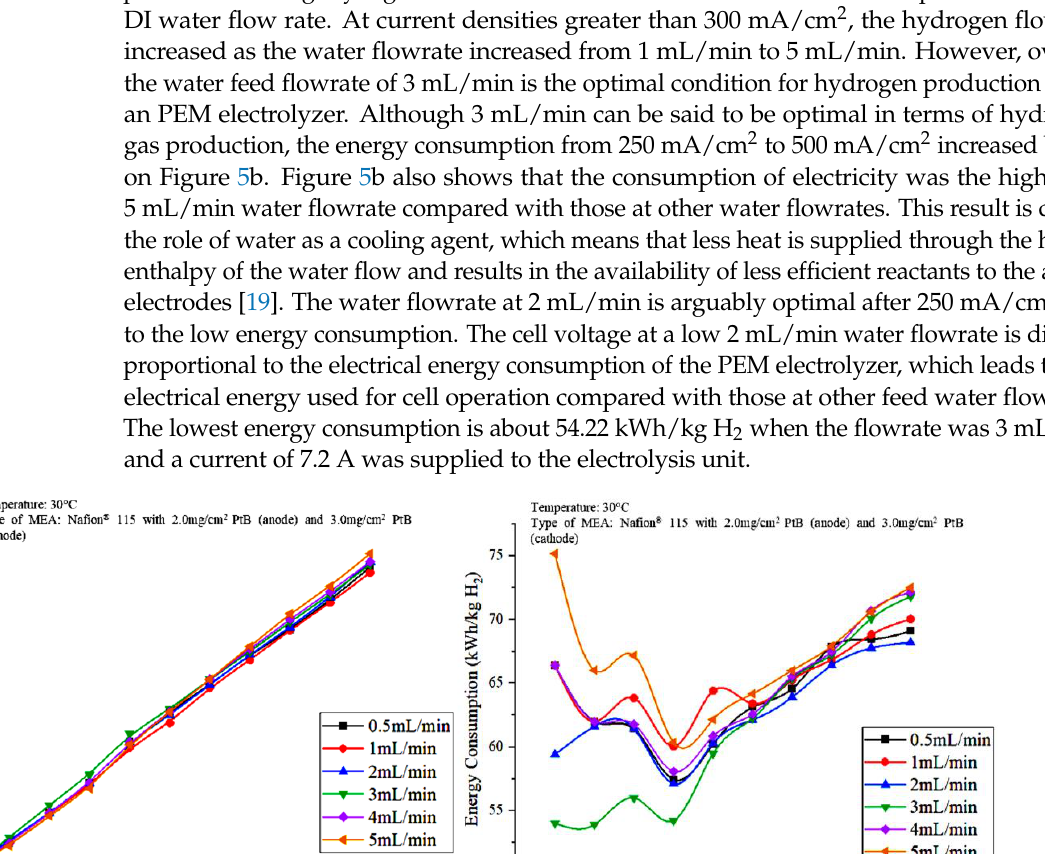
( b ) Figure 6. Effects of water flowrate on PEM electrolyzer performance ( a ) energy efficiency versus current density ( b ) energy efficiency versus water flow rate When the current density was kept constant at 250 mA/cm 2 and the water flowrate was 3 mL/min, the hydrogen produced was highest, and the energy consumption was low. Meanwhile, electricity consumption shows no definite trend against water flowrate, whereas the energy consumption and hydrogen production increased in the water flowrate order of 3, 0.5, 2, and 4 mL/min, followed by 5 mL/min when the current den- sity was kept constant. The performance of the PEM electrolyzer was also evaluated in terms of energy efficiency. As shown in Figure 6b, the water flowrate of 3 mL/min re-